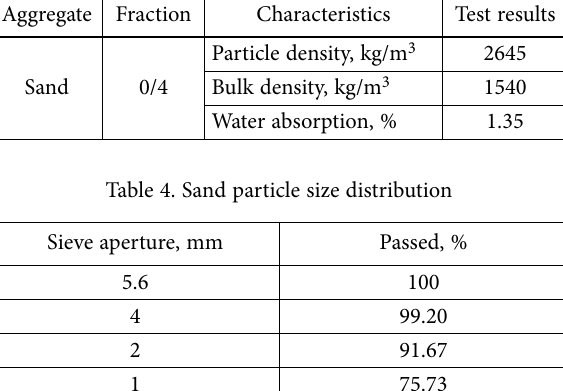
Table 3. Physical properties of sand Aggregate Fraction Characteristics